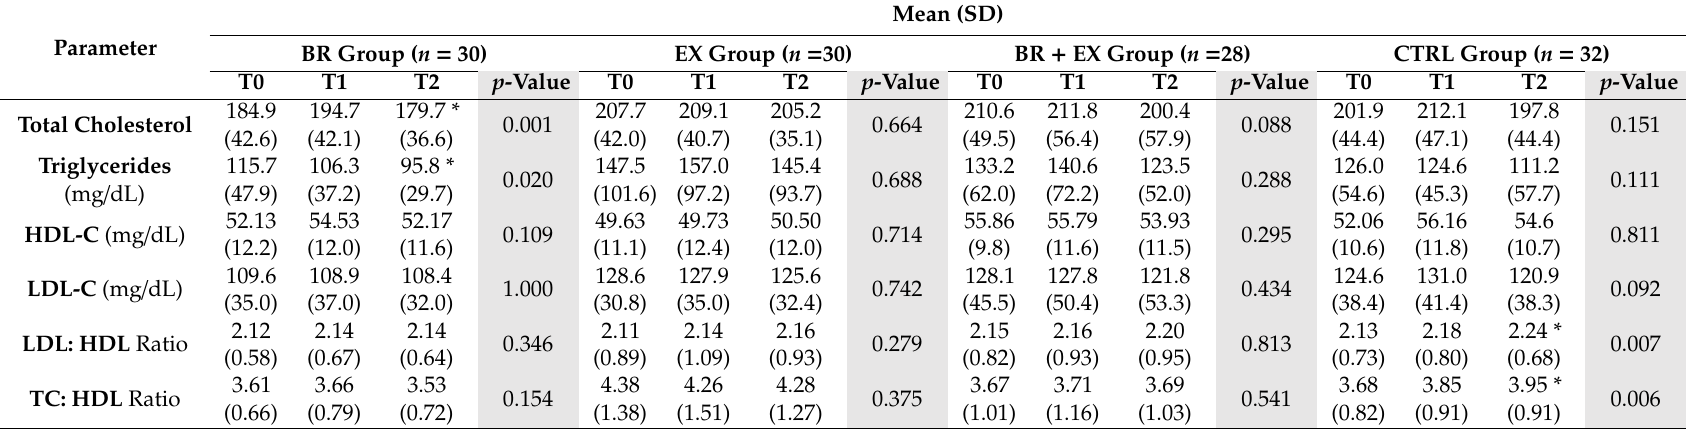
Table 4. Changes in general blood-based health profile parameters (lipid profile, LDL: HDL- and cholesterol: HDL-ratio) in all 4 di ff erent intervention groups during the 24-week intervention